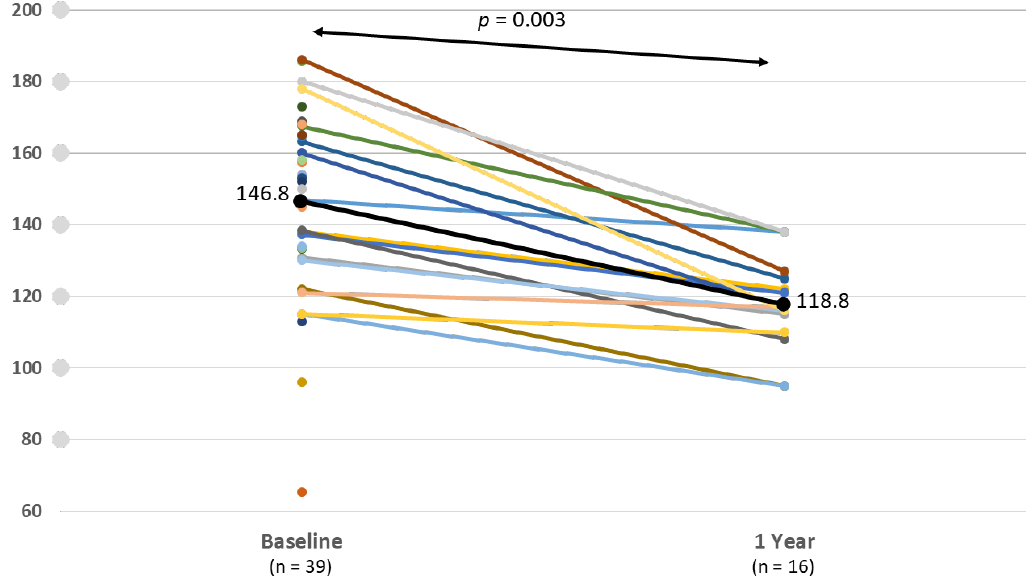
Figure 2. Changes in tricuspid valve regurgitation over time: before and after pulmonary valve implantation, as seen on transthoracic echocardiography. The proportion of greater than moderate tricuspid valve regurgitation decreased after pulmonary valve implantation.